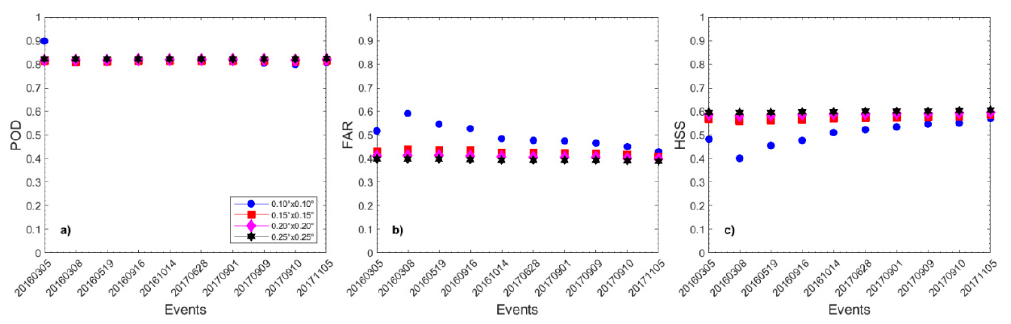
Figure 10. ( a ) POD, ( b ) FAR, and ( c ) HSS scores calculated by comparing the RAINBOW outputs with the GRISO data (taken as reference) on different regular grids for 10 case studies. A minimum cumulated rain threshold is set at 0.25 mm.